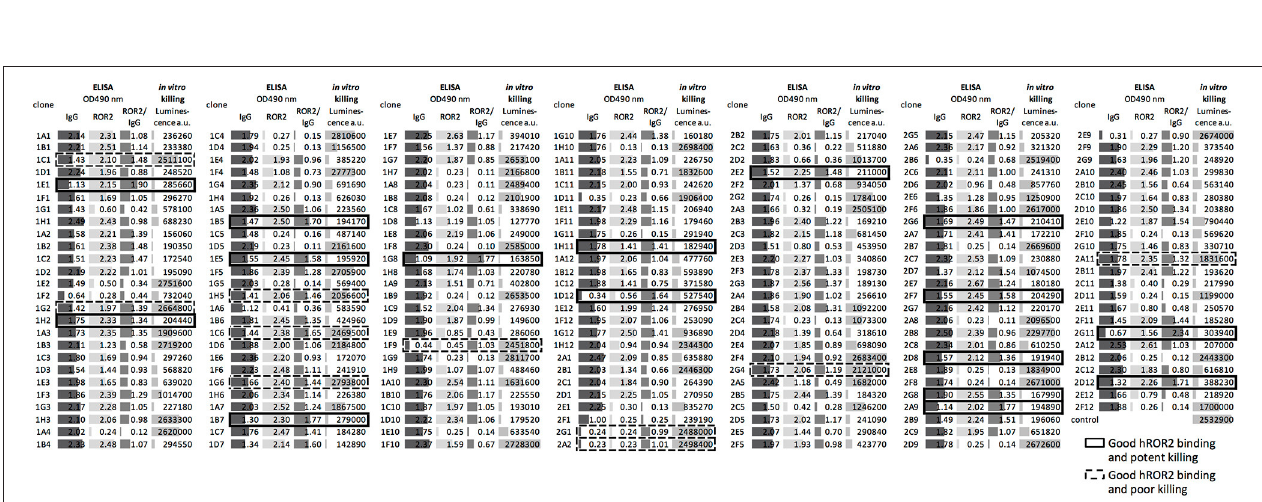
FIGURE 4 | Direct screening of supernatants from sorted clones for identification of hROR2-binding clones with high potency as an ADC. Supernatants from single-cell sorted clones were screened for hROR2 binding and additionally for potency in a secondary ADC cell killing assay. Therefore, IgG levels (dark gray bars) and binding to hROR2-ECD-Twin-Strep were measured by ELISA (lightest gray bars), presented as ratios of OD490nm hROR2-ECD-Twin-Strep-binding / IgG levels (medium gray bars). Additionally, the supernatants were used to assess potency of the antibodies for cell killing in a secondary ADC assay. For this, EMT6-hROR2 cells were incubated with a 5-fold dilution of clonal supernatant for 30min. Next, an anti-human Fc γ coupled via a cleavable linker to PNU-159682, a potent cytotoxic small molecule, was added and incubated with the cells and clonal supernatant for 3 days. EMT6-hROR2 cells incubated with only secondary ADC, but no clonal supernatant served as a control. Viable cells were then quantified using a luminescence-based cell viability assay. Lower luminescence values [arbitrary units (a.u.)] indicate more potent killing (light gray bars). The IgG 1 /Ig κ library of mouse 1357 is shown as a representative. Examples of clones with strong hROR2 binding and potent (solid cell border) as well as poor in vitro killing (dashed lines) are